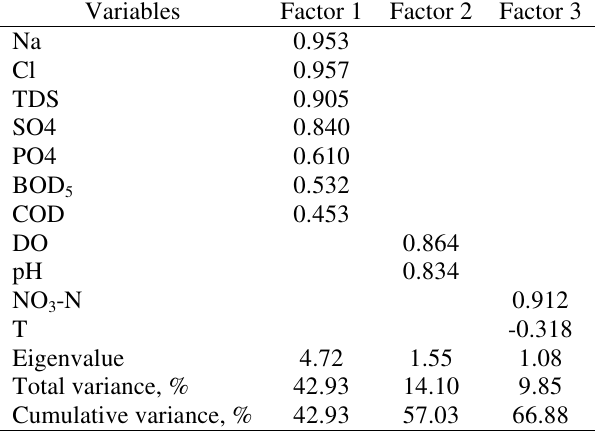
Table 2 . Factor loading matrix, eigenvalues and variances.